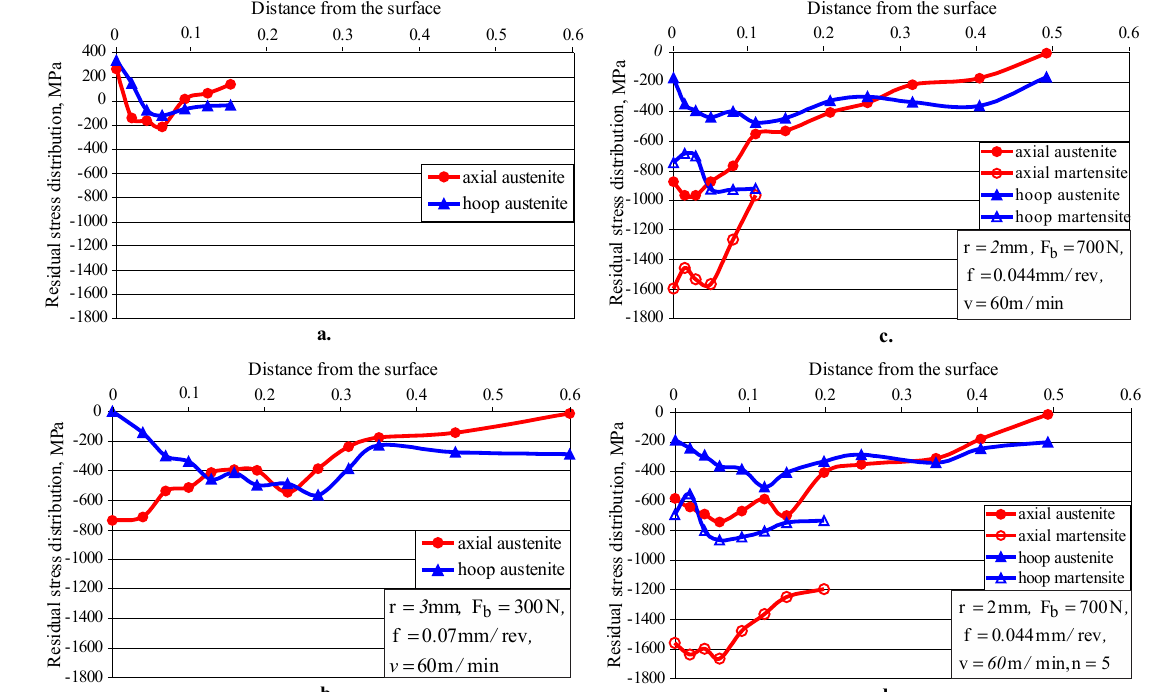
Figure 14. Residual stress distribution: ( a ) processed by turning only (austenitic phase); ( b ) smoothing single-pass DB (austenitic phase); ( c ) hardening single-pass DB (austenitic and martensitic phases); ( d ) hardening five-pass DB (austenitic and martensitic phases).